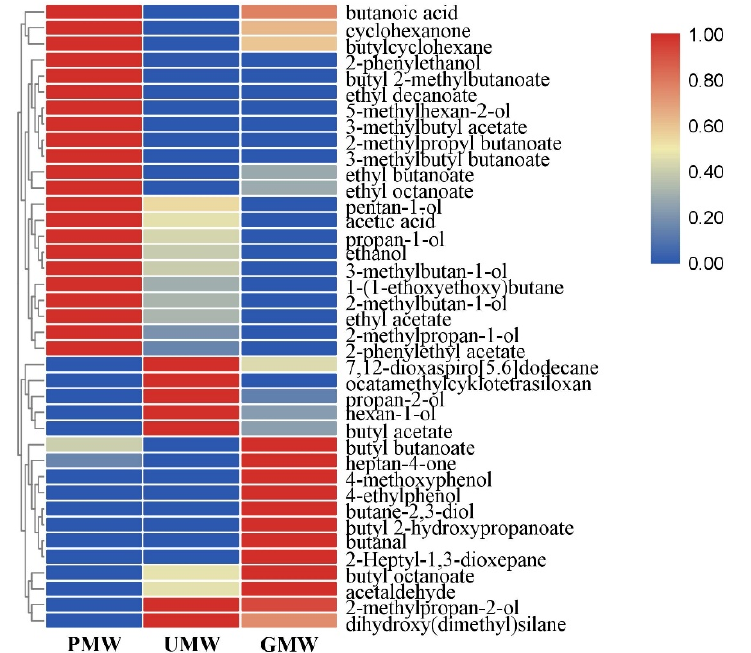
Figure 4. Heatmap of volatile compounds in three obtained MWs. PMW, Monascus wine using polished rice as a raw material; UMW, Monascus wine using unhusked rice as a raw material; GMW, Monascus wine using germinated rice as a raw material.